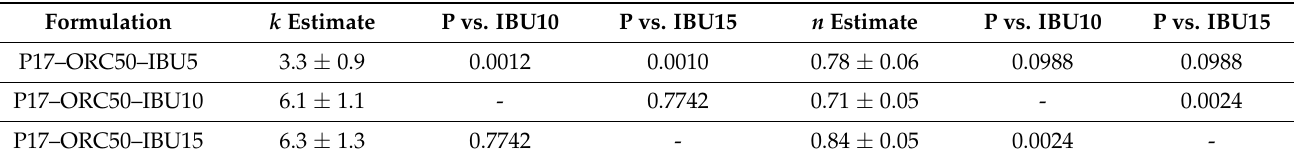
Table 8. Statistical summary of Korsmeyer–Peppas model fit. Raw ( µ g/mm 2 ) data used; means ± sd, from six units of each. p -values from pairwise comparisons in ANOVA post-hoc test (Holm’s